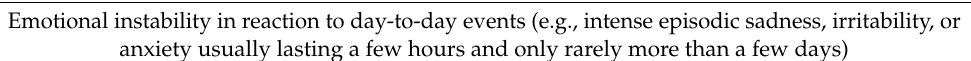
Table 1. Ticking boxes . Diagnostic criteria for borderline personality disorder. Chronic Feelings of